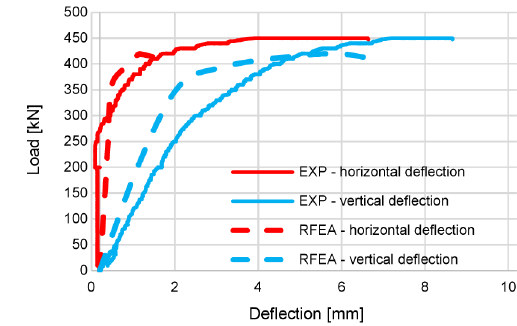
Fig. 10. Load-deflection curve for specimen A